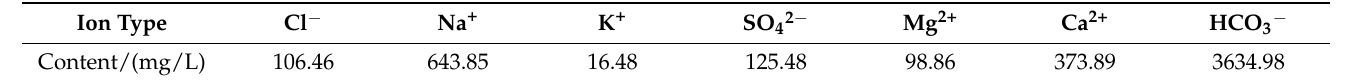
Table 3. Detail compositions of the mineralized water with mineralization 5000 mg/L.